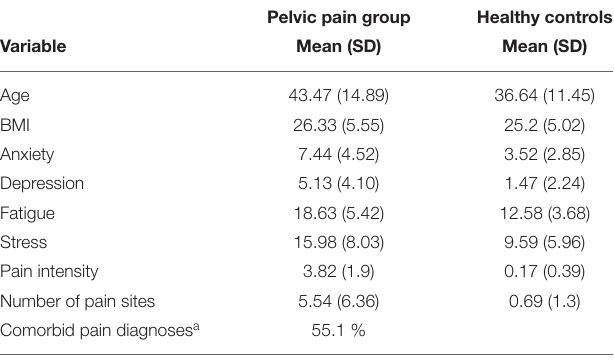
TABLE 2 | Overview of the covariates of interest in the two groups (mean and standard deviation), and proportion of patients with comorbid pain diagnoses